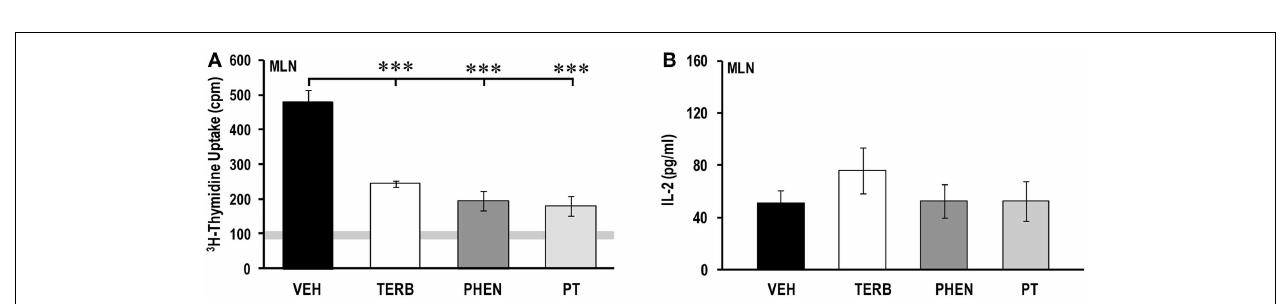
12days after adjuvant challenge. (A) All drug treatments suppressed proliferation of MLN cells compared withVEH treatment. Horizontal light gray bar demonstrates non-specific background. (B) IL-2 production did not differ between treatment groups. N = 8. *** p <